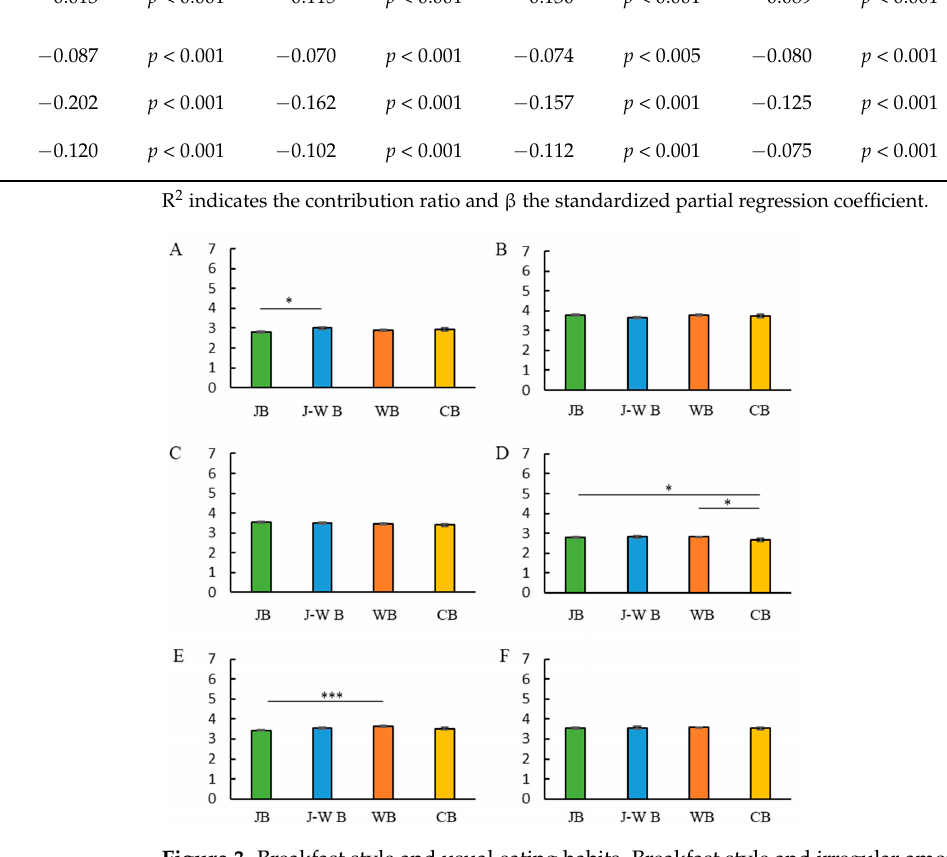
Figure 3. Breakfast style and usual eating habits. Breakfast style and irregular amount of food score ( A ). Breakfast style and less chewing ( B ). Breakfast style and large amounts of food ( C ). Breakfast style and frequent eating out ( D ). Breakfast style and nutritional imbalance ( E ). Breakfast style and excessive salt intake ( F ). * p < 0.05, *** p < 0.001 (Dunn’s test).